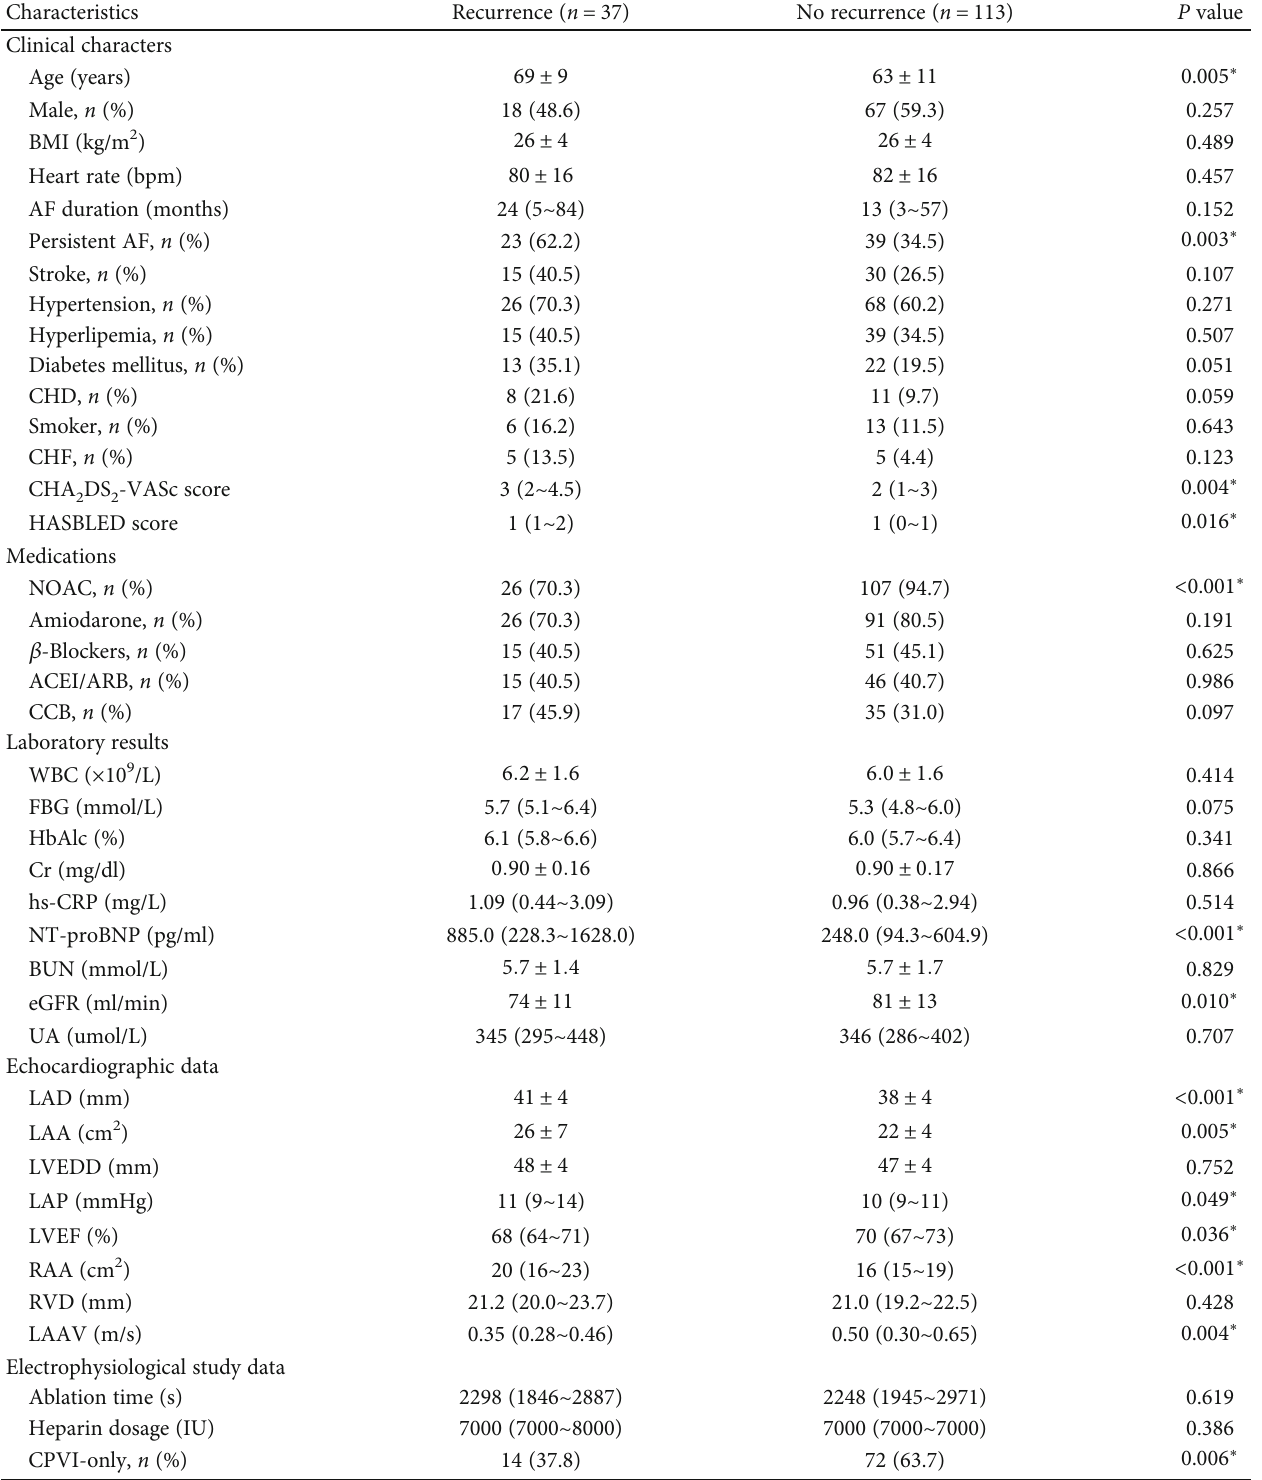
Table 1: Baseline characteristics of patients with and without AF